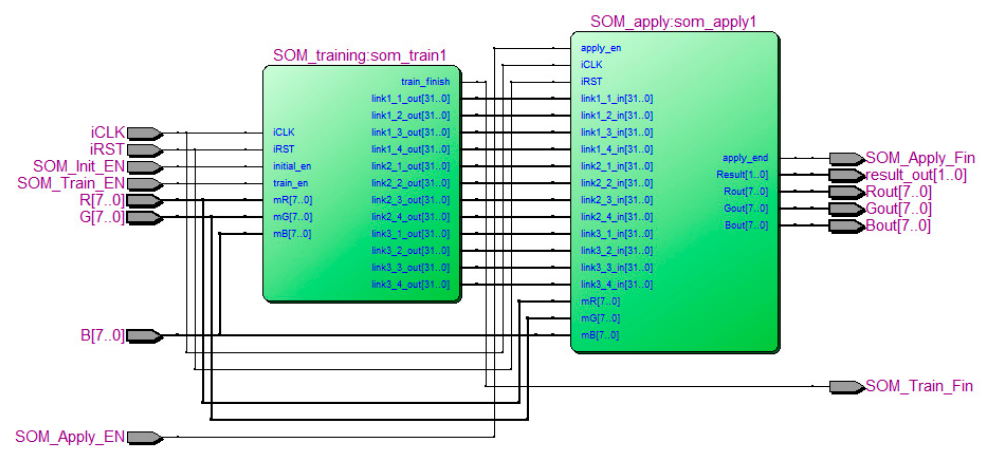
Figure 11. RTL-schematic diagram of the SOM-based image segmentation module.